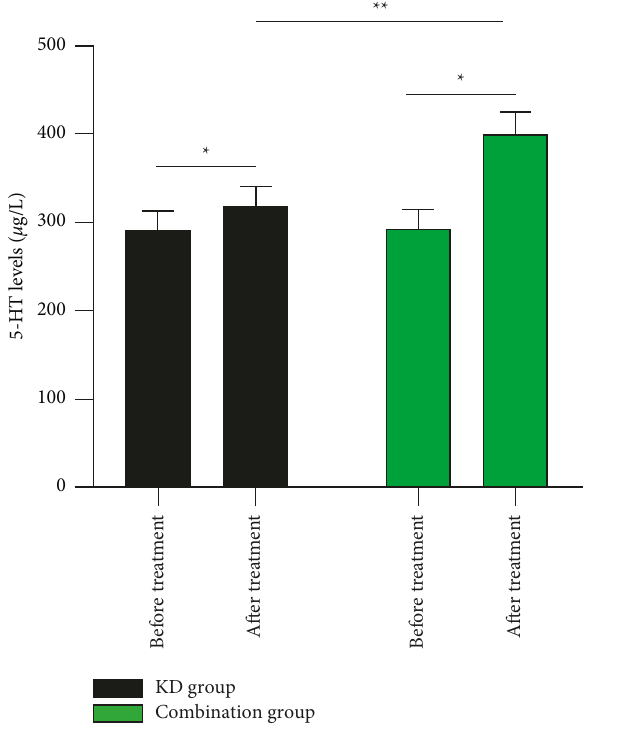
Figure 5: 5-HT levels between the two groups of children before and after treatment. ∗ Comparison between the same group before and after treatment, P < 0 . 05; ∗∗ comparison between groups after treatment, P < 0 . 05. Figure